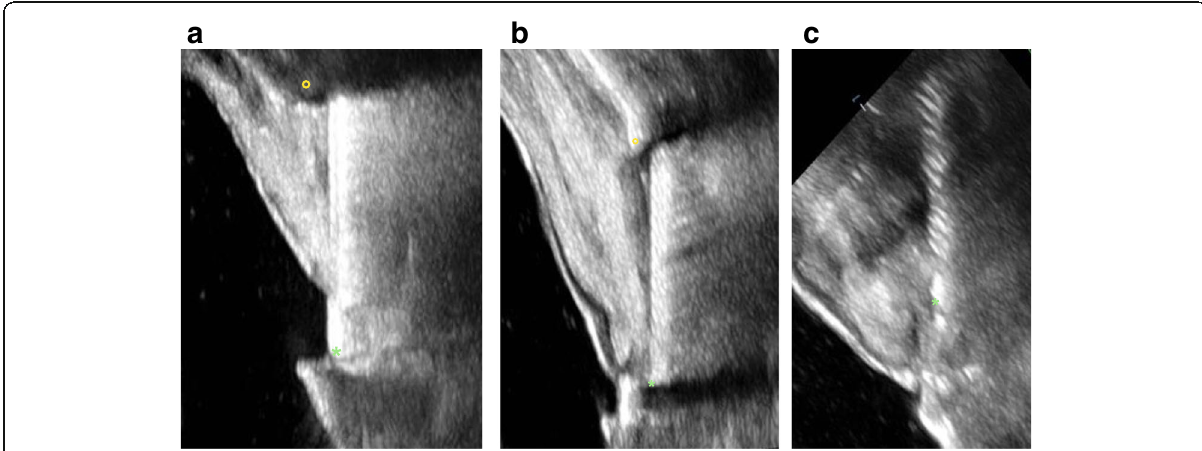
Fig. 10 a Ultrasonic imaging at the implant in region 14 revealed a buccal bone loss up to the 12th thread (asterisk marks the implant-abutment interface; circle marks the bone). b Ultrasonic imaging at the implant in region 13 revealed a buccal bone loss up to the 14th thread (asterisk marks the implant-abutment interface; circle marks the bone). c Ultrasonic imaging at the implant in region 12 could not be visualized from the buccal side due to its anatomical situation (subnasal position). Imaging palatal to the implant showed bone loss up to the 13th thread. The palatal image is severely distorted because it was not possible to place the probe parallel to the implant on the oblique palate, and so it was impossible to visualize the apical bone edge (asterisk marks the implant-abutment